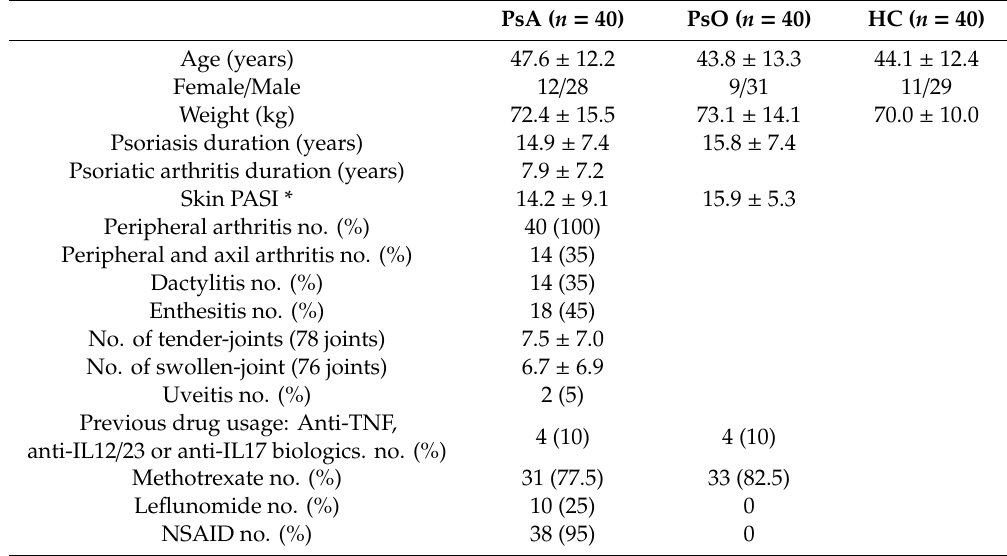
Table 1. Demographics of psoriatic arthritis patients (PsA), psoriatic patients without arthritis (PsO), and healthy controls